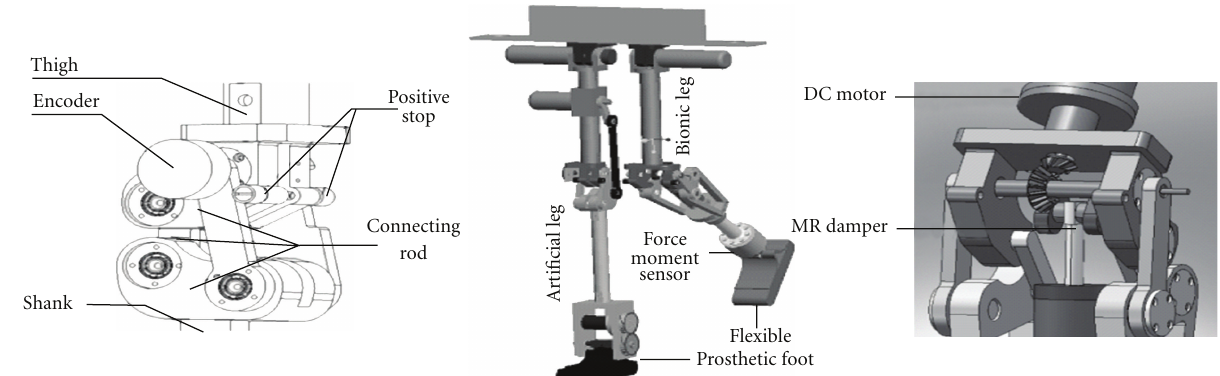
Figure 1: The test-bed in heterogeneous configuration and 4-bar knee joint